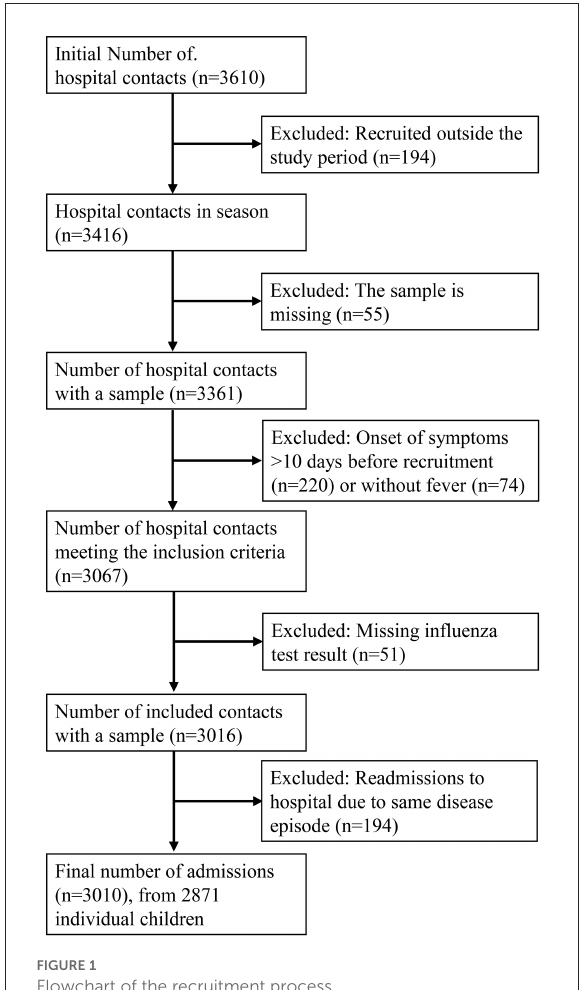
FIGURE1 Flowchart of the recruitment